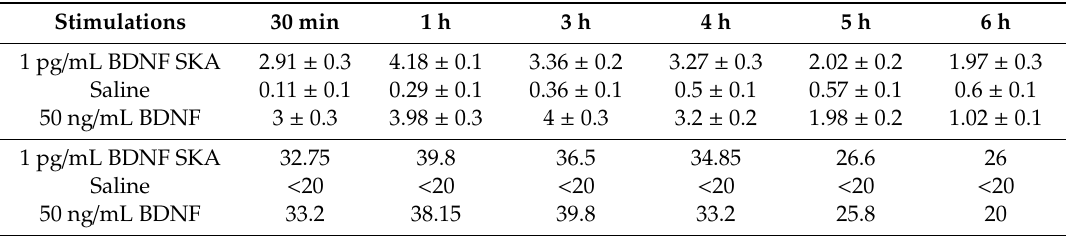
Table 1. The Papp values obtained on intestinal barrier model and plasmatic human absorption derived from Papp